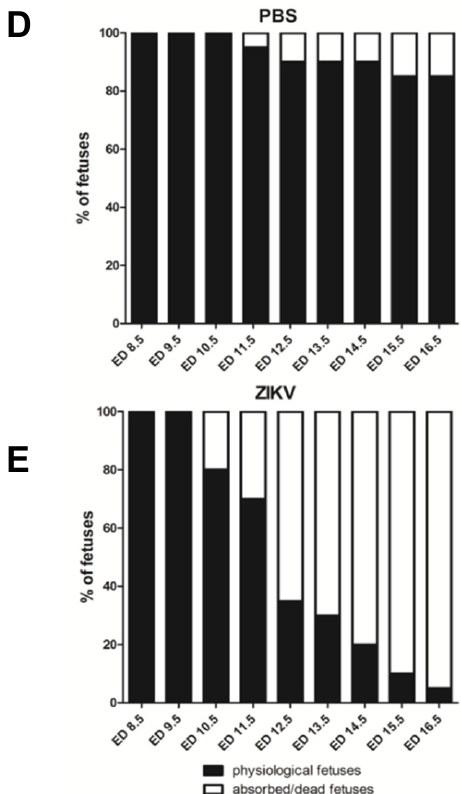
Figure 1. Embryonic day (ED) 4.5: ( A ) + ( B ) A two-dimensional echocardiography image of the uterus showing the implantation site (uterus horn 1 (“U1”) and uterus horn 2 (“U2”) framed by white crosses) next to the bladder (“B”, shown in black) on ED 4.5.; ED 9.5: ( A ) + ( B ) Echogenic foci of the uterus horns are prominent on ED 9.5.; ED 13.5: ( A ) the placenta and the developing fetuses are visible (“P”, framed by white crosses, “F”) and the umbilical cord (“Uc”), ( B ) the placenta is visible in the uterus lumen (“P”, framed by white crosses, “L”, shown in black) and indistinguishable fetal structures (“FR”); ED 14.5: ( A ) growing fetus (“F”), with distinct structures such as the fetal head (“FH”), the umbilical cord (“Uc”) and the placenta (“P”, framed with white crosses) on ED 14.5, ( B ) the uterus lumen is either filled with fetal residues including the placentas (“FR”, “P”, framed with white crosses) or empty on ED 14.5; ED 16.5: ( A ) highly developed fetus with distinguishable fetal thorax, the fetal heart and paws (“F”, “FC”, “FP”) and the placenta (“P”, framed with white crosses) on ED 16.5, ( B ) Uterus lumen (“L”, shown in black) including placentas with unclear fetal residuals on ED 16.5; ( C ) Analysis of uterus diameter using USI at di ff erent timepoints during pregnancy ( n = 8- 10dams per group, graph represents 2–3 independent measurements per uterus). Di ff erences between individual groups were analyzed by Mann–Whitney test. Error bars indicate the interquartile range (IQR) from the median. Asterisks represent statistically significant di ff erences between two groups: ns = non-significant, *** p = 0.0002; ( D ) Tabular summary of the ultrasound based findings as identified in ( A , B ) in the mock-infected mice ( n = 20 fetuses, 4 examined fetuses / uterus ampoules per mouse and timepoint); ( E ) Tabular summary of the ultrasound based findings as identified in ( A , B ) in the Zika virus (ZIKV)-infected mice ( n = 20 fetuses, 4 examined fetuses / uterus ampoules per mouse and